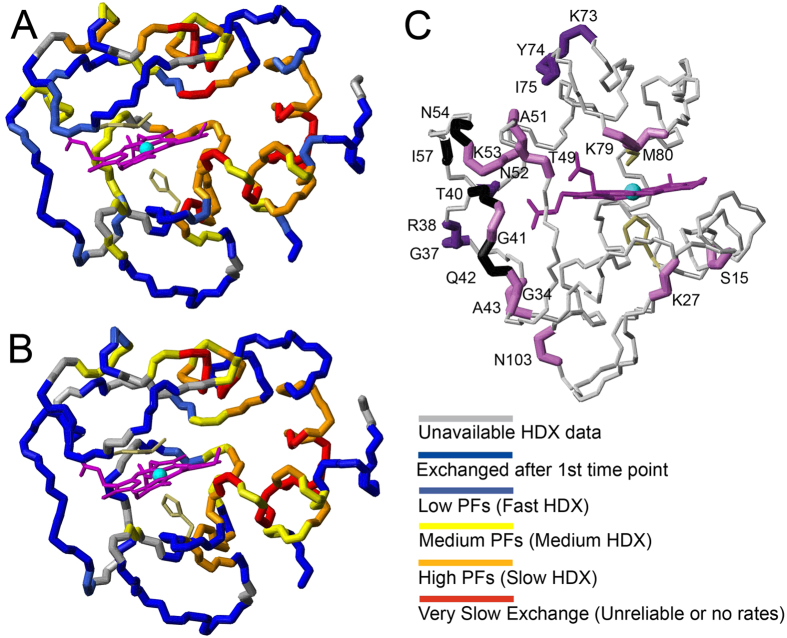
PF mapping for H-ferricyt.PFs are colour coded as indicated on (A) the WT and (B) the G41S X-ray structures2021. The WT cartoon representation in Fig. 1A can be used to aid orientation. (C) H/D exchange difference profile mapped onto the X-ray structure of the G41S variant. Residues highlighted in violet have PF > 0.5 in WT but are fully exchanged in G41S, residues highlighted in dark violet have [∆(LogPFWT-LogPFG41S) > 0.5] and residues highlighted in black have PF > 0.5 in WT but are unassigned for G41S.